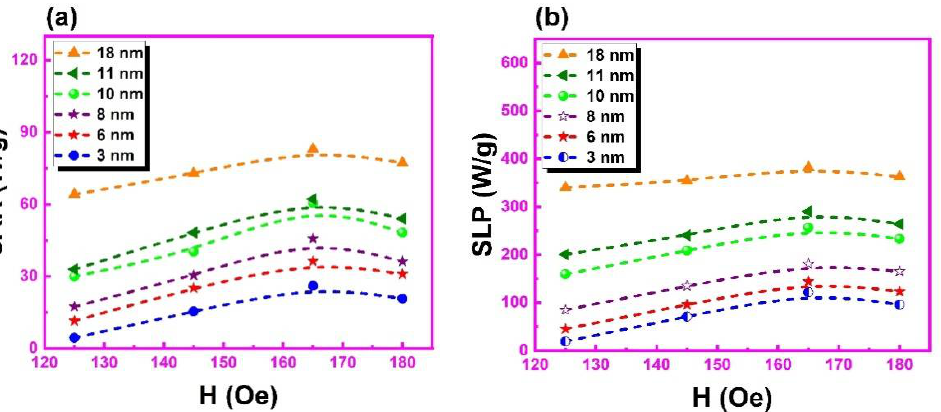
Figure 13. ( a ) SAR and ( b ) SLP of Co 15 Ni 85 NPs milled at 1425 rpm for 100, 200, 300, 500, 1000, and 1200 min as a function of AC field amplitude at a fixed frequency of 425 kHz.